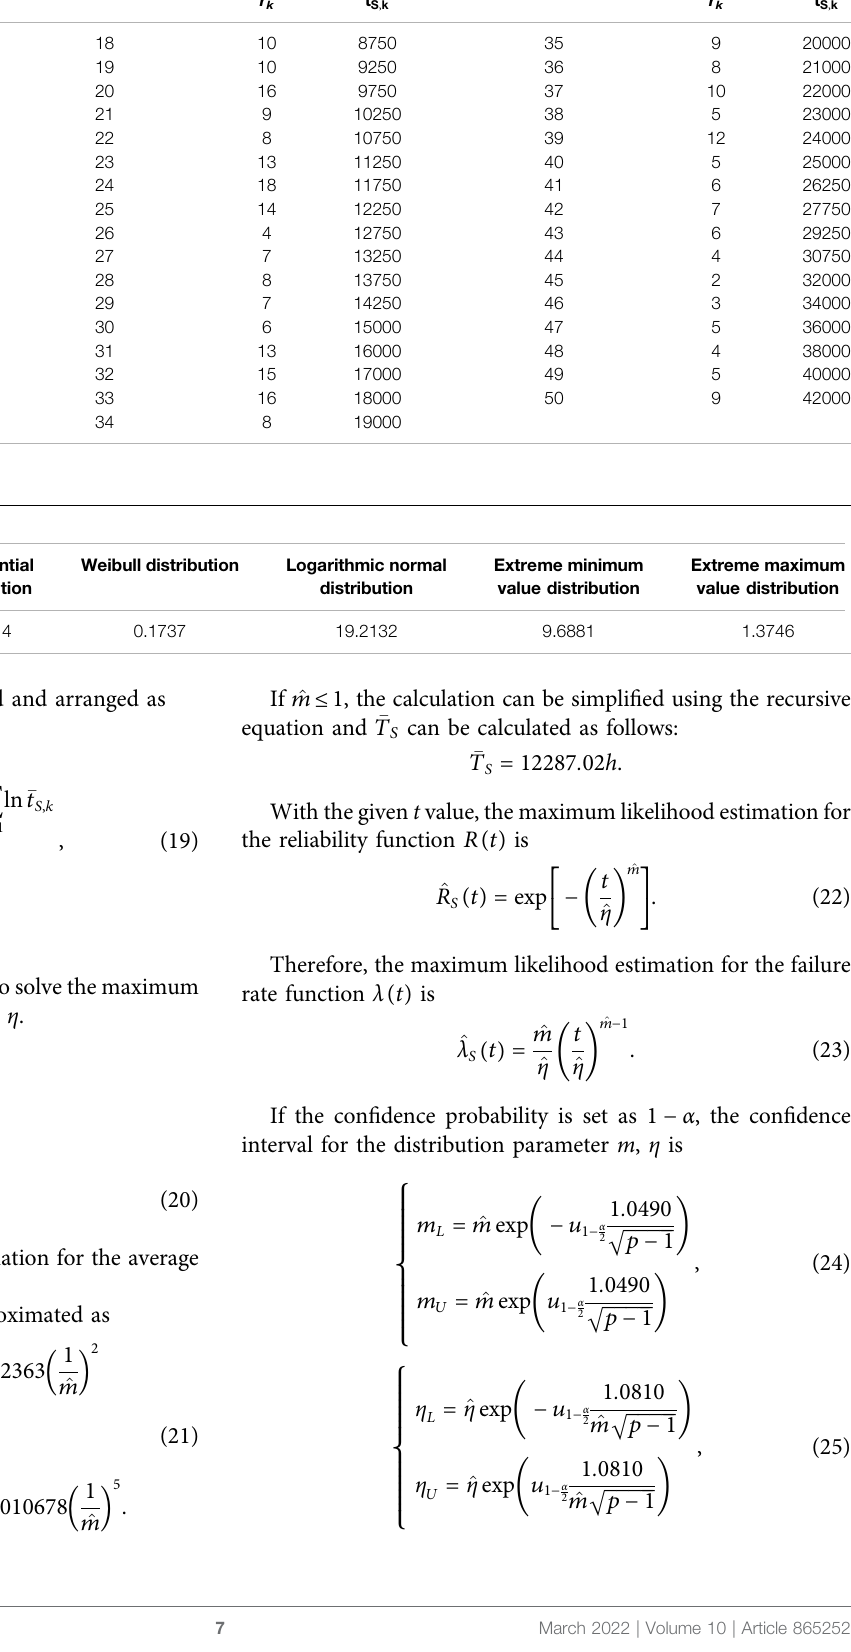
TABLE 5 | The system simulation life data. Sequence number